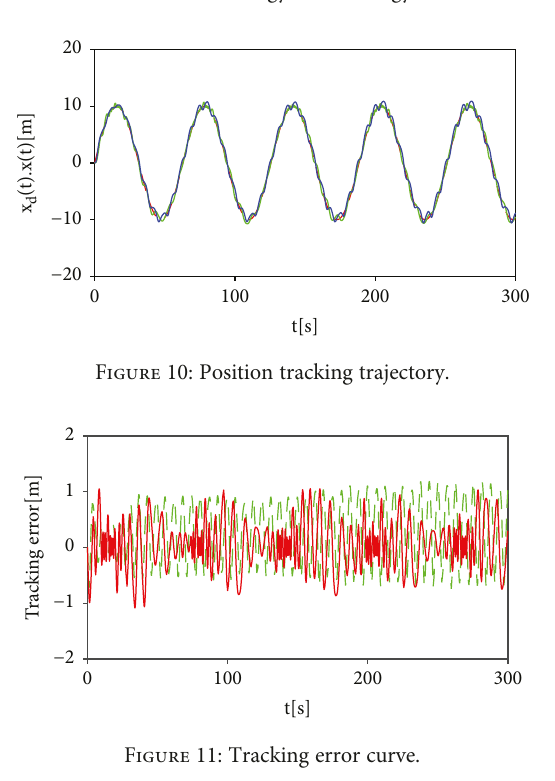
Figure 9: Total energy in the energy tank.